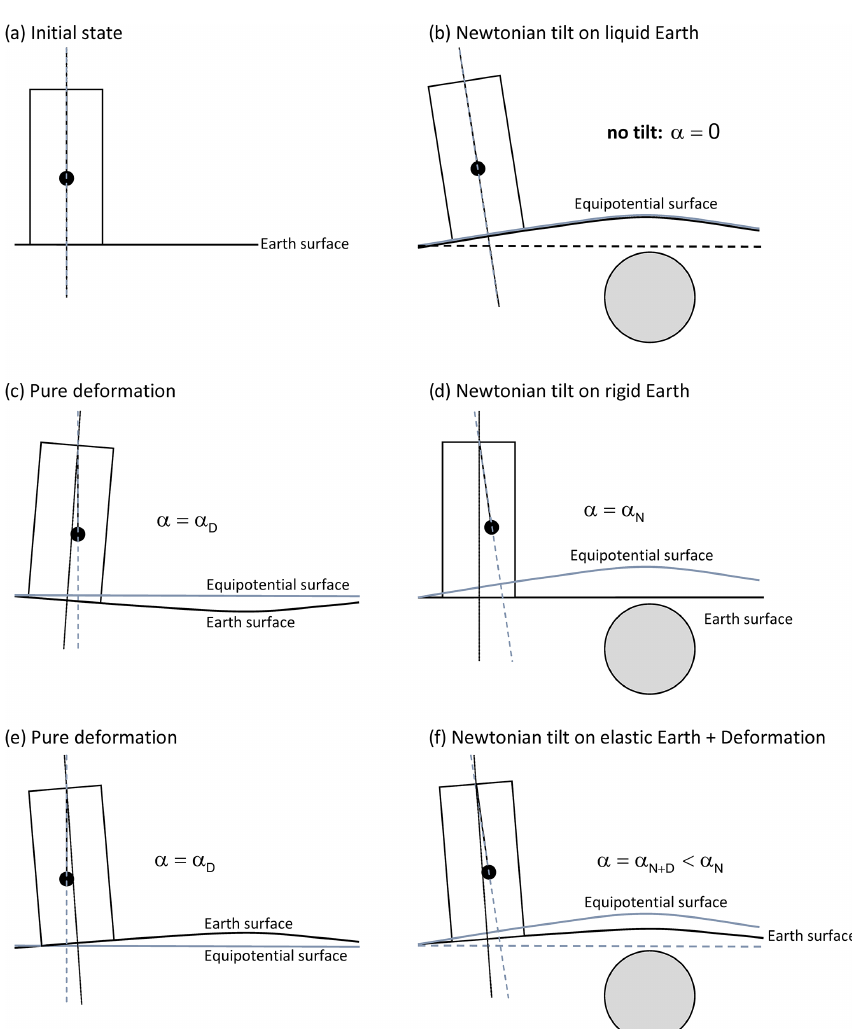
Figure 1. Gravitational (Newtonian) tilt and deformation. The sphere represents an arbitrary surplus mass (interior or exterior); lines show the equipotential surface (blue solid), the planet surface (solid black), the tilt sensor axis (dotted black) and the plumb line (blue dashed). (a) Initial state, (b) no tilt on a liquid planet, (c, e) tilt due to deformation, (d) Newtonian tilt on a rigid planet, and (f) tilt on a deformable planet, including both Newtonian tilt and tilt due to surface